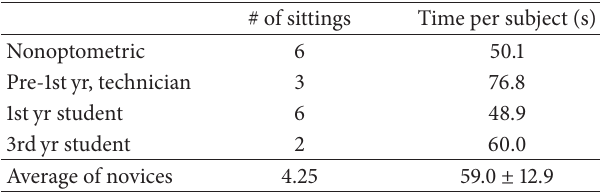
Figure 6: Reviewer accuracy by optometric education level. Table 3: Time spent in data review, per subject (time not recorded when expert reviewed data).